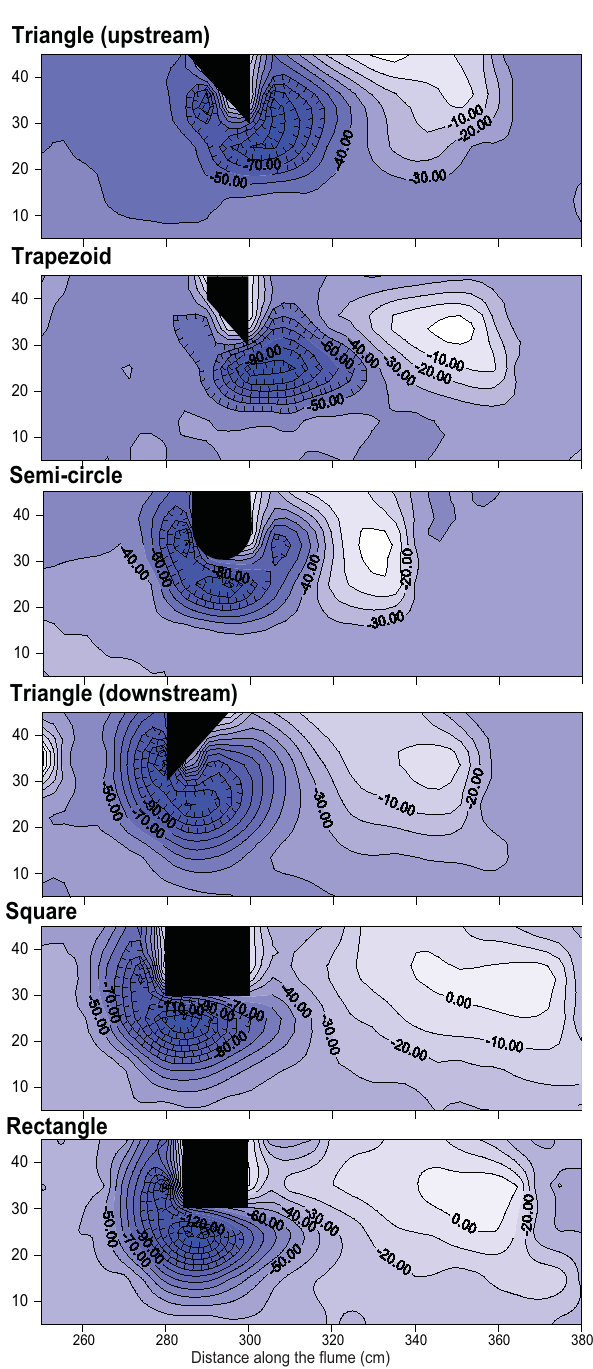
Fig. 2. Plan view of flume-bed topography for pool-riffle sequences formed by different shaped obstructions to flow.